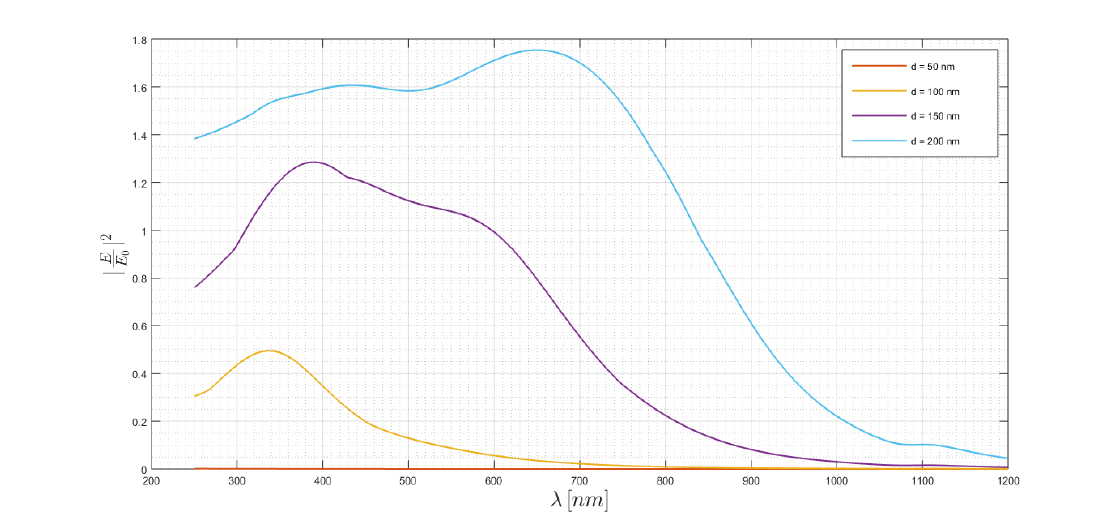
Figure 10. Hole diameter sweep on the aluminum nanostructure.